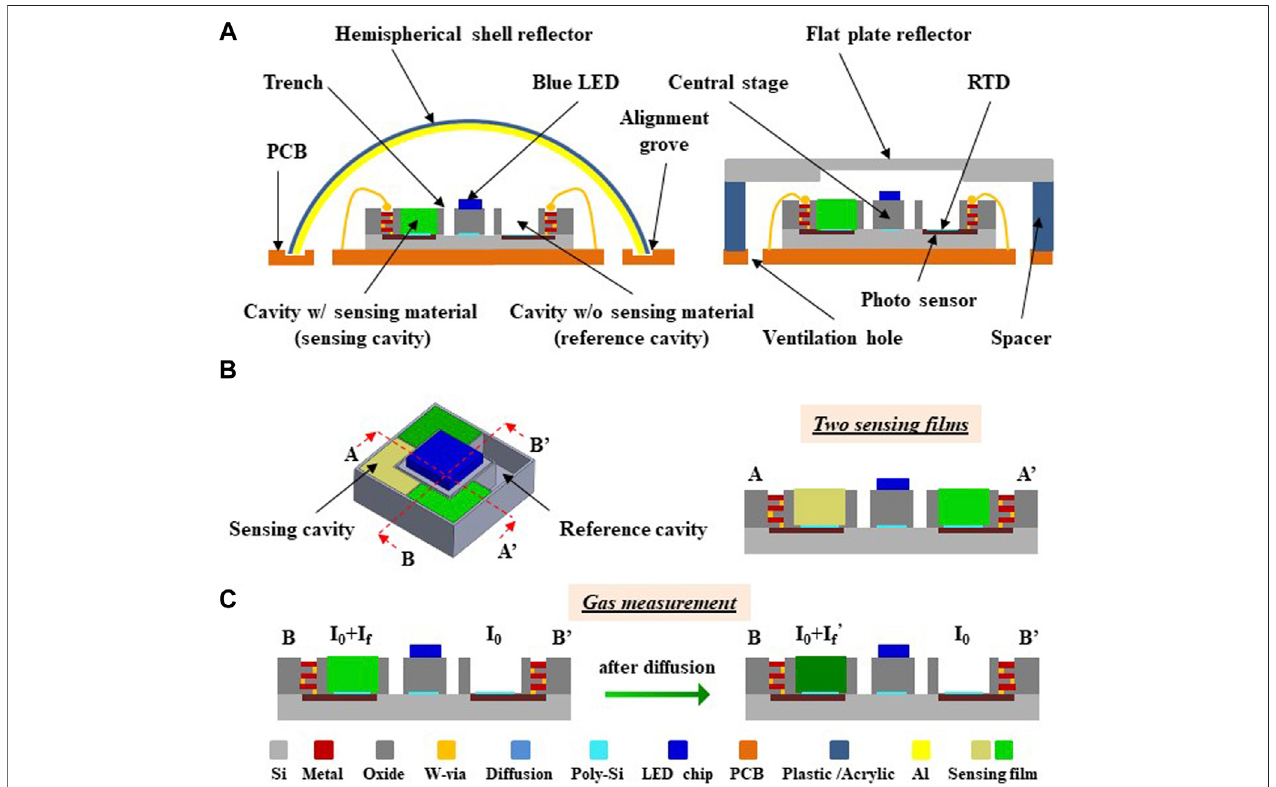
FIGURE 1 | (A) Schematic of the presented gas sensor design consisted of the CMOS-MEMS gas sensing chip, the sensing material, the LED chip, and the light re fl ectors, (B) schematic of the presented CMOS-MEMS gas sensing chip with sensing materials in an isometric view and cross-sectional view.